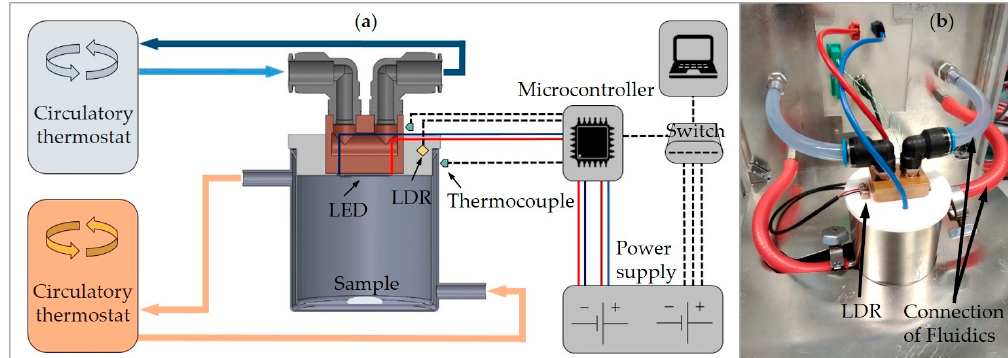
Figure 1. Design of the MLTIS: ( a ) schematic representation; and ( b ) photo of an aging unit with corresponding sensors, electrical, and fluidic connections. The two green thermocouples are mounted on the backside of the copper block and the sample chamber.